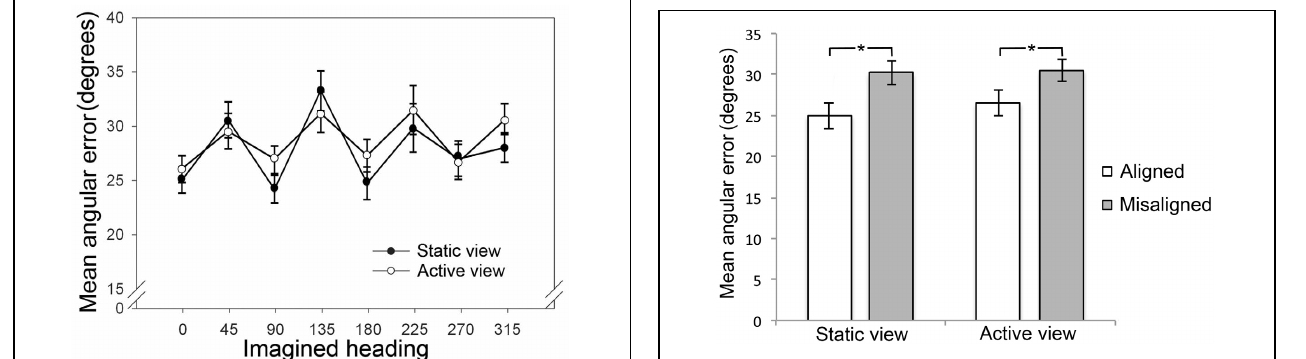
FIGURE 2 | Results of the judgement of relative direction (JRD) task in Experiments 1A,B. Mean angular error in degrees, shown as a function of imagined heading for Experiment 1A (static view—filled symbols) and Experiment 1B (active view—open symbols). Error bars represent ± 1 normalized within-subjects error of the mean (Cousineau, 2005).